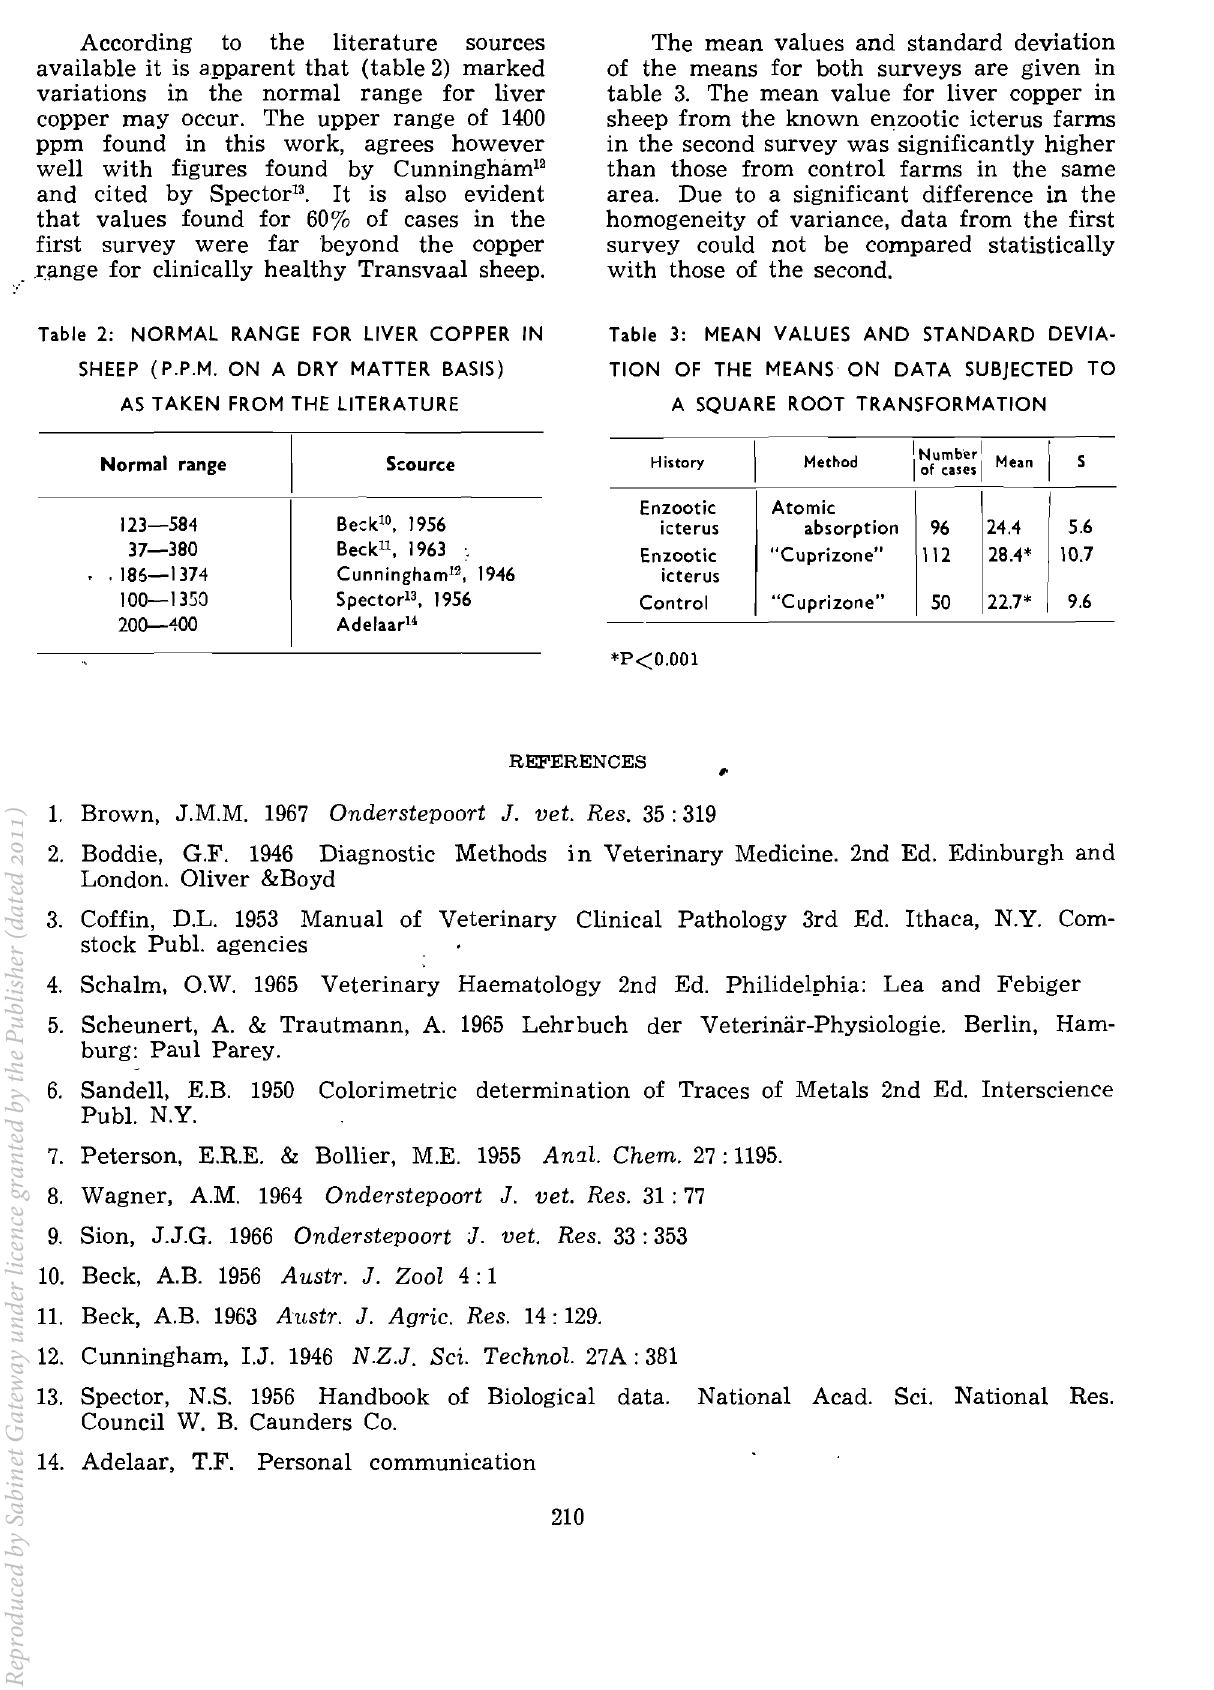
table 3. The mean value for liver copper in in the second survey was significantly higher than those from control farms in the same area. Due to a significant difference in the homogeneity of variance, data from the first